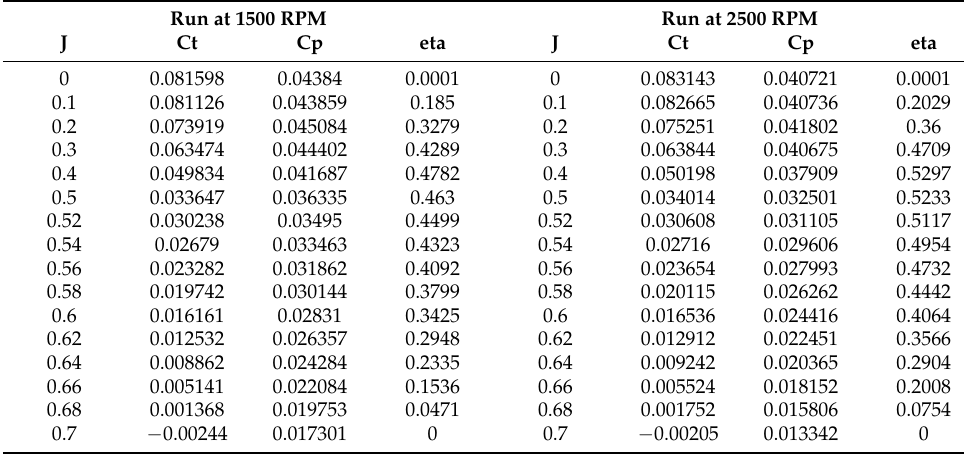
Table A22. BEMT 18 × 10 APC propeller